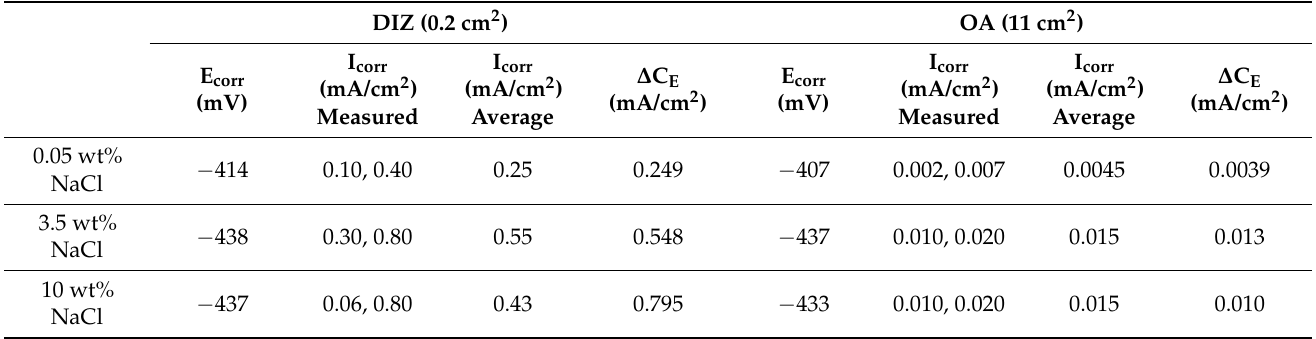
Table 8. Electrochemical measurements for UNS S15500 alloy segmented sample in all test salinities.